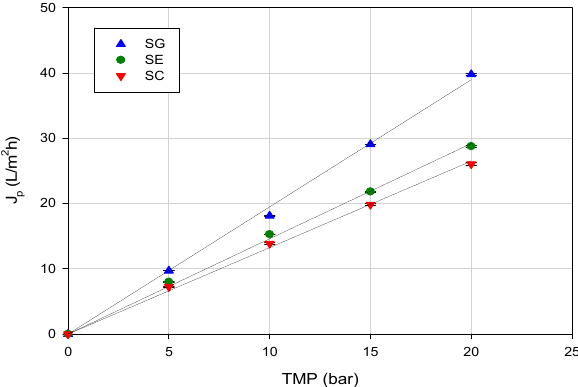
Figure 3. Water flux versus transmembrane pressure for selected RO membranes (operating conditions: temperature, 20 ± 1 °C; feed flowrate, 360 L/h).